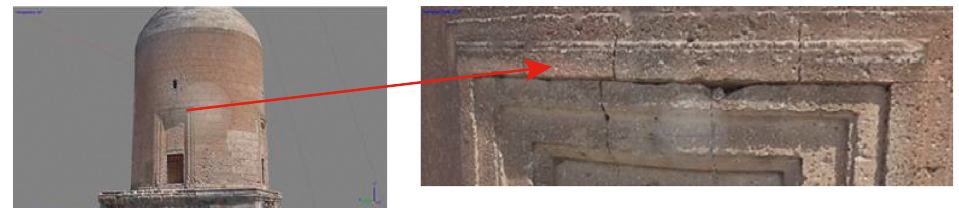
Figure 4: Reconstructed three-dimensional (3D) mesh model of the historic Sircali cupola.